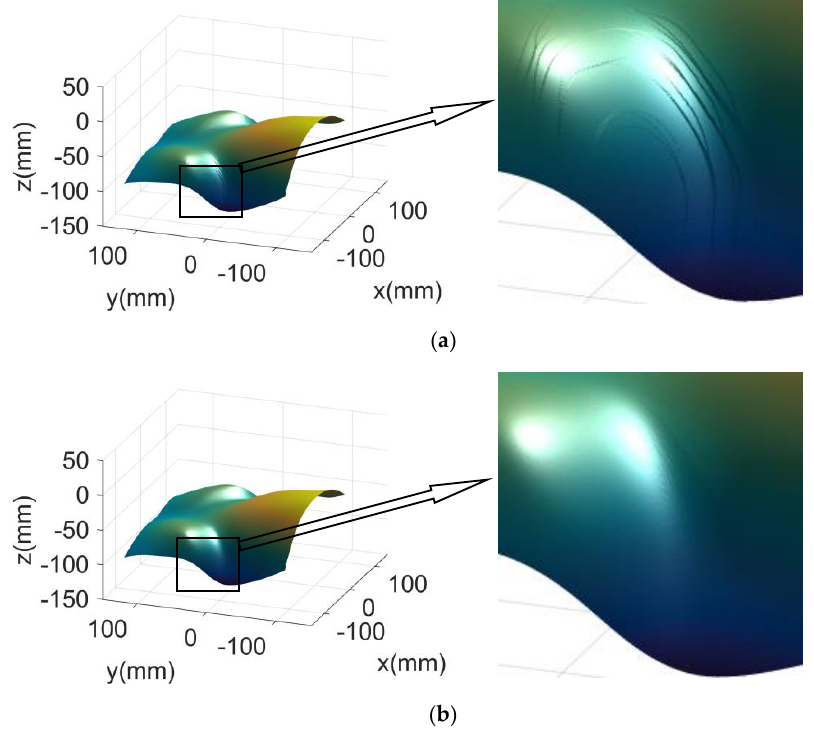
Figure 9. Three-dimensional reconstruction results using 3D WT method with different scale-factor intervals. ( a ) Scale-factor interval is 1; ( b ) Scale-factor interval is 0.1.